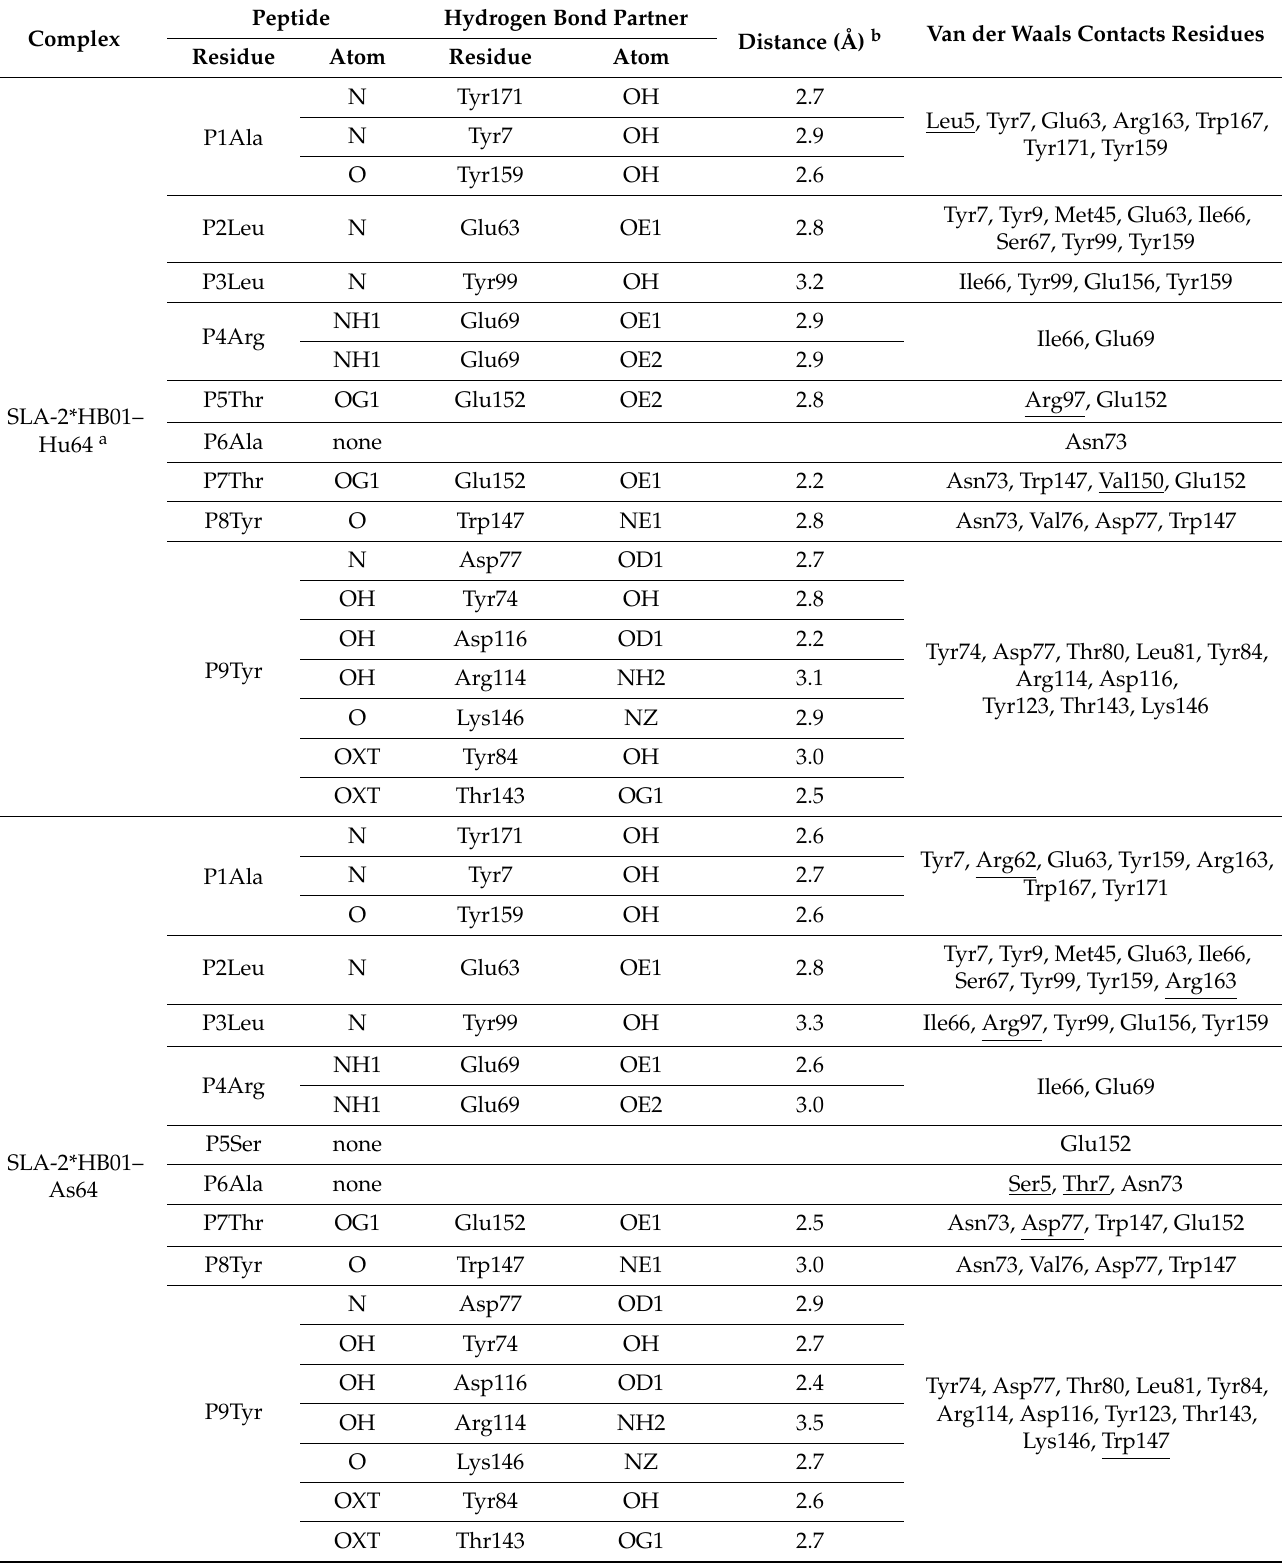
Table 3. Peptide hydrogen bonds and van der Waals interactions in the SLA-2*HB01 heavy